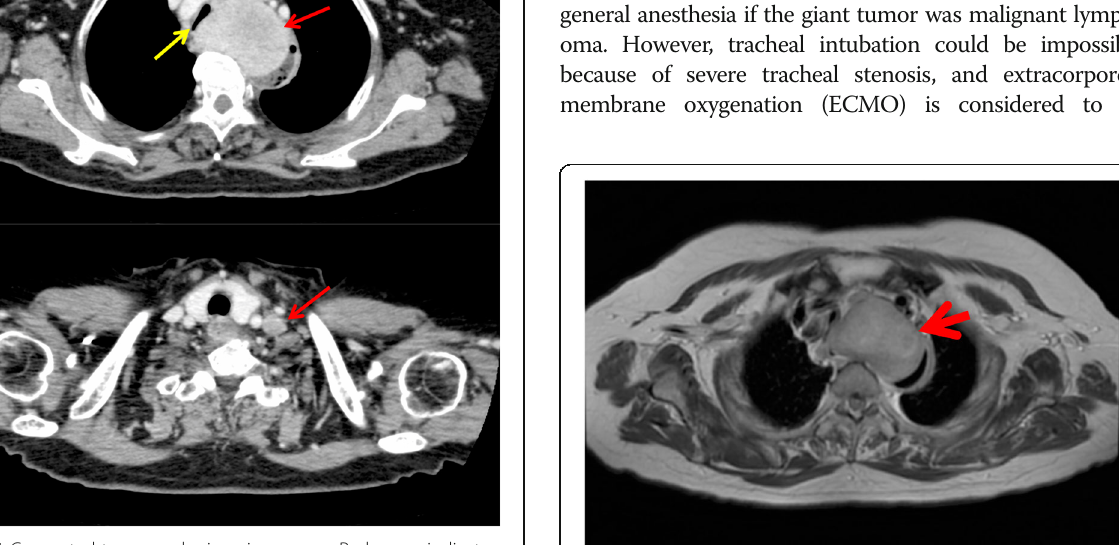
Fig. 1 Computed tomography imaging scan. a Red arrow indicates the mediastinal tumor and yellow arrow indicates tracheal stenosis. b Red arrow indicates supraclavicular lymph node enlargement